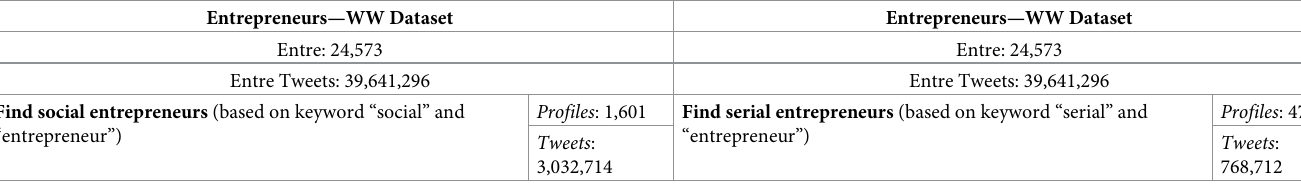
Table 10. Number of social entrepreneurs and serial entrepreneurs.